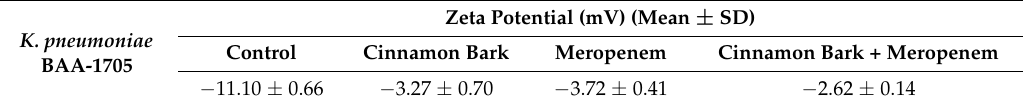
Table A3. Raw data of zeta potential measurement.